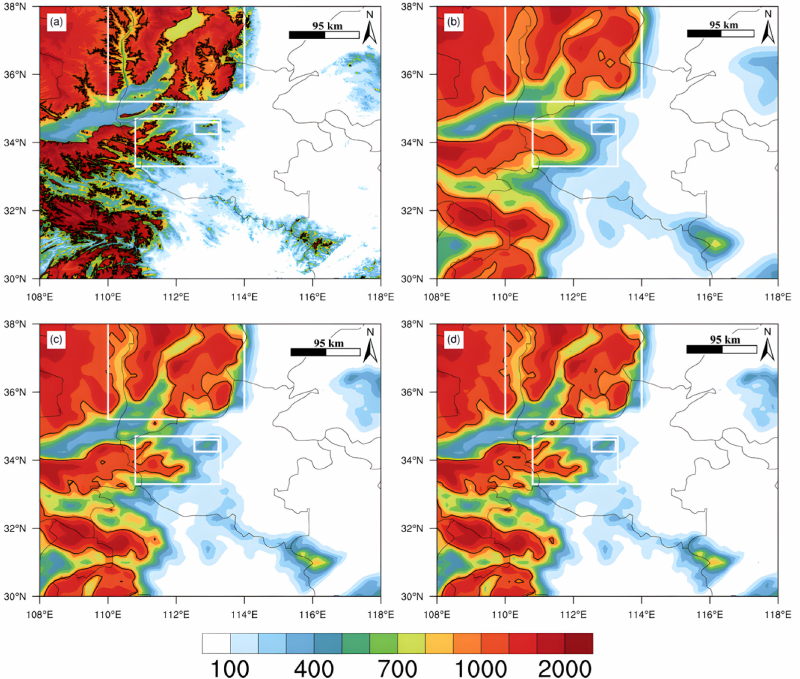
Figure 4. Orographic height (unit: m): ( a ) the new initial orography before processing, ( b ) the model’s original orography, ( c ) new orography processed using the bidirectional one-dimensional filter, and ( d ) new orography processed using the direct two-dimensional filter. The solid black lines are the 1000 m contour lines. The two large white rectangles represent Taihang Mountains (top) and Funiu Mountains (bottom). The small white rectangle in the lower rectangle represents Songshan mountain, which is part of Funiu Mountain.